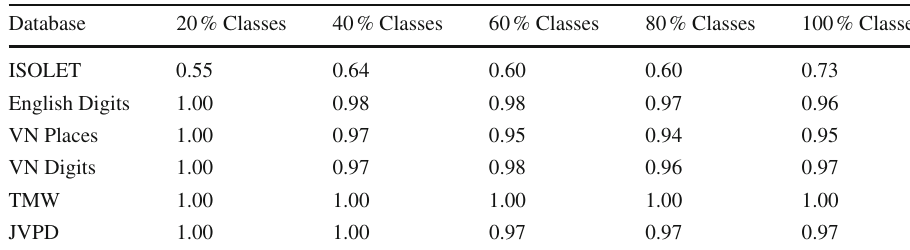
classification rate on increment update class